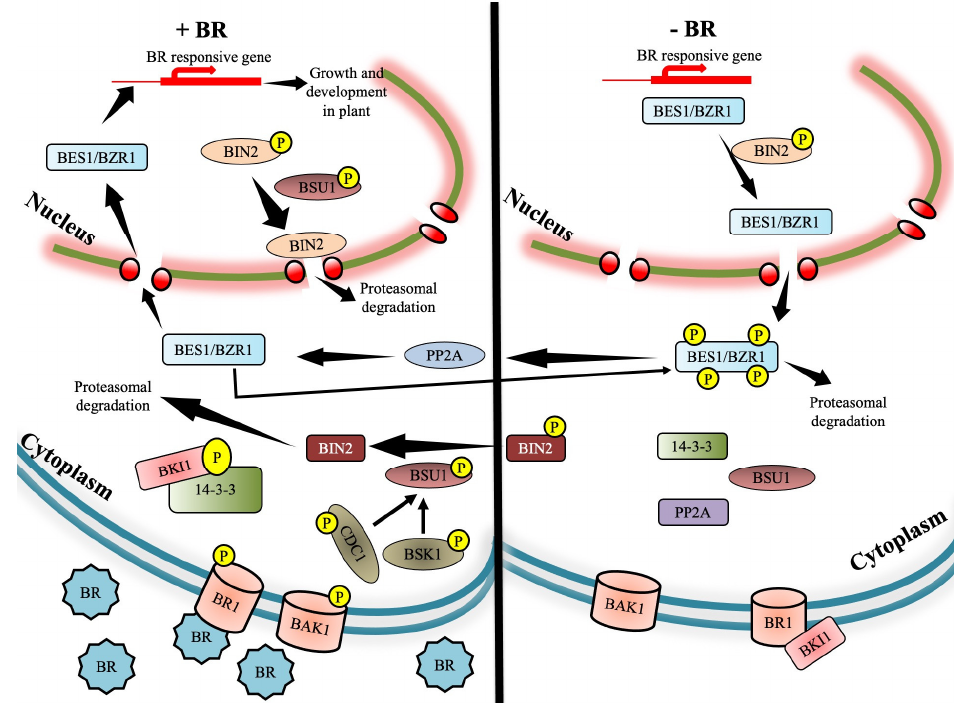
Figure 2. A comprehensive diagram depicting the brassinosteroid signaling pathway in plants.